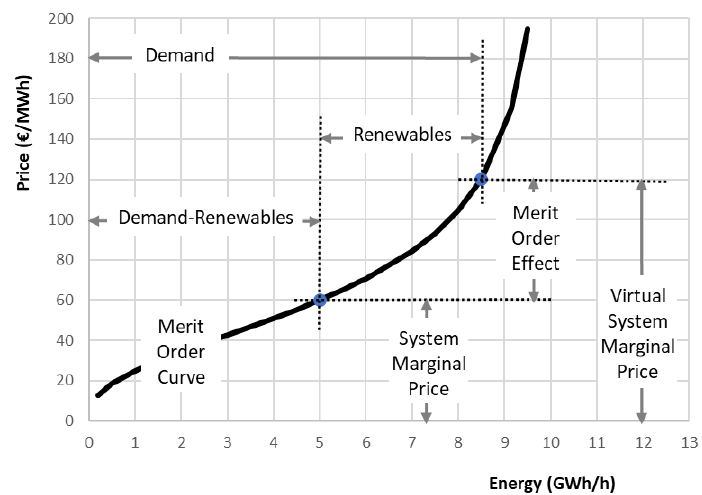
Figure 1. Definition of the merit order effect (MOE) using the demand and supply curve (merit order curve) in the day-ahead electricity market.